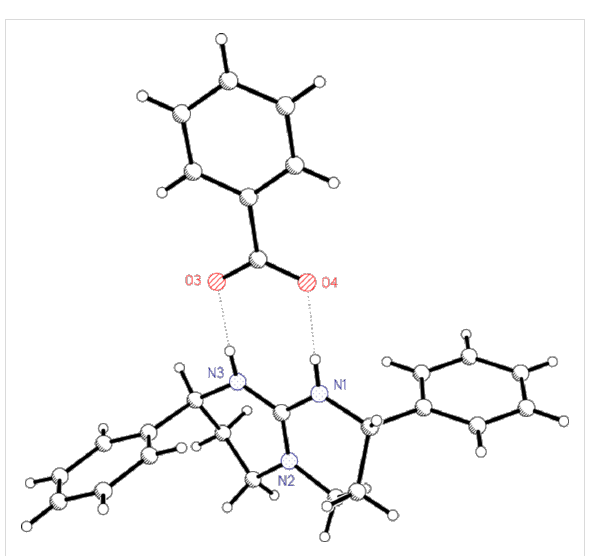
Figure 2: Crystal structure of guanidine 10 as a benzoate salt. Only one of the ion pairs is shown for the sake of